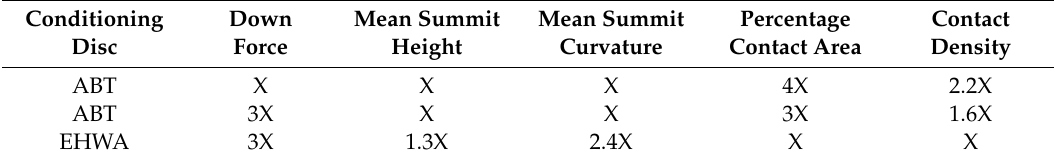
Table 1. Micro-texture parameters relative comparison after 30 minutes of pad